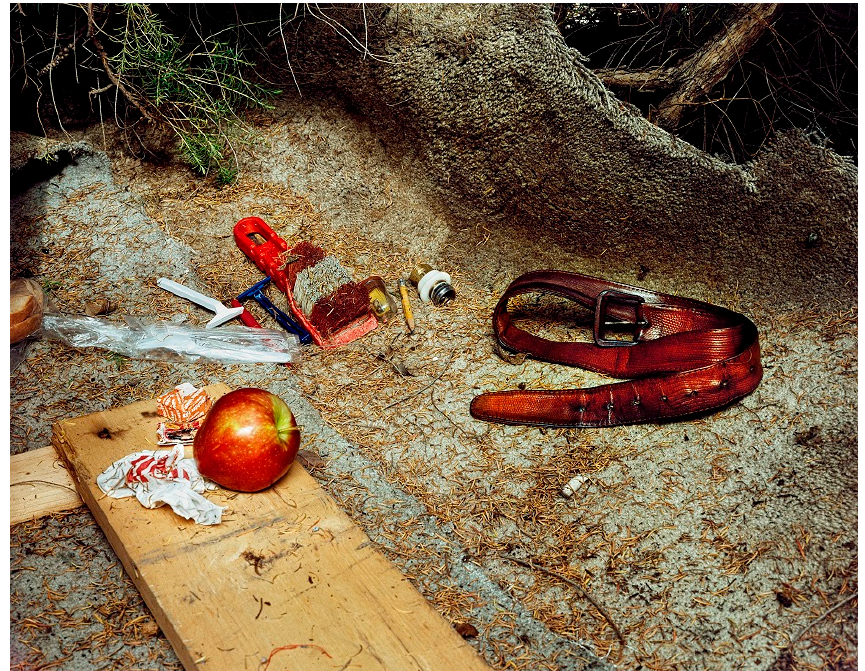
Figure 7. Anthony Hernandez, Landscapes for the Homeless #29 (1989), © Anthony Hernandez.